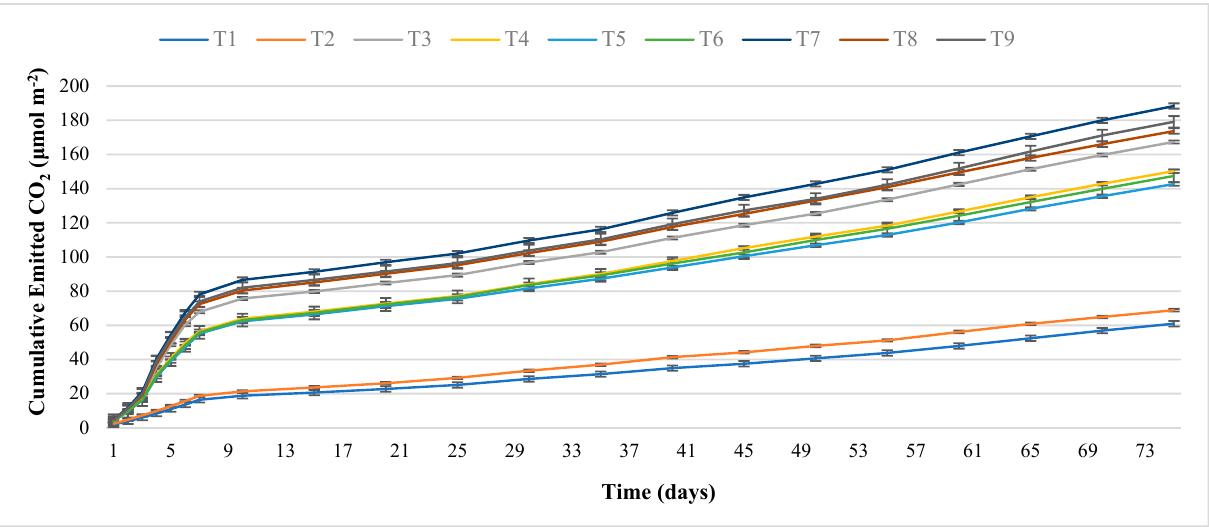
Figure 3. Effect of treatments on cumulative soil CO 2 flux emission. Bar errors show ± standard error of three replications.